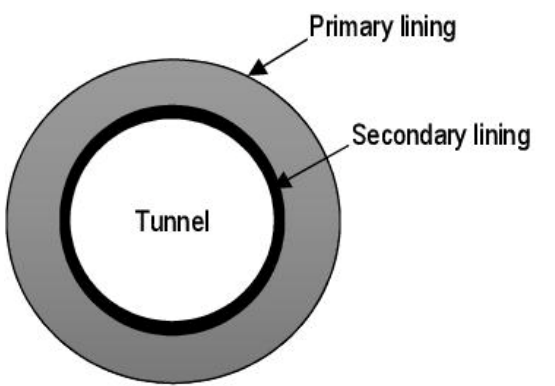
Figure 4. Typical positions of secondary and primary linings of tunnels, adapted from [126].